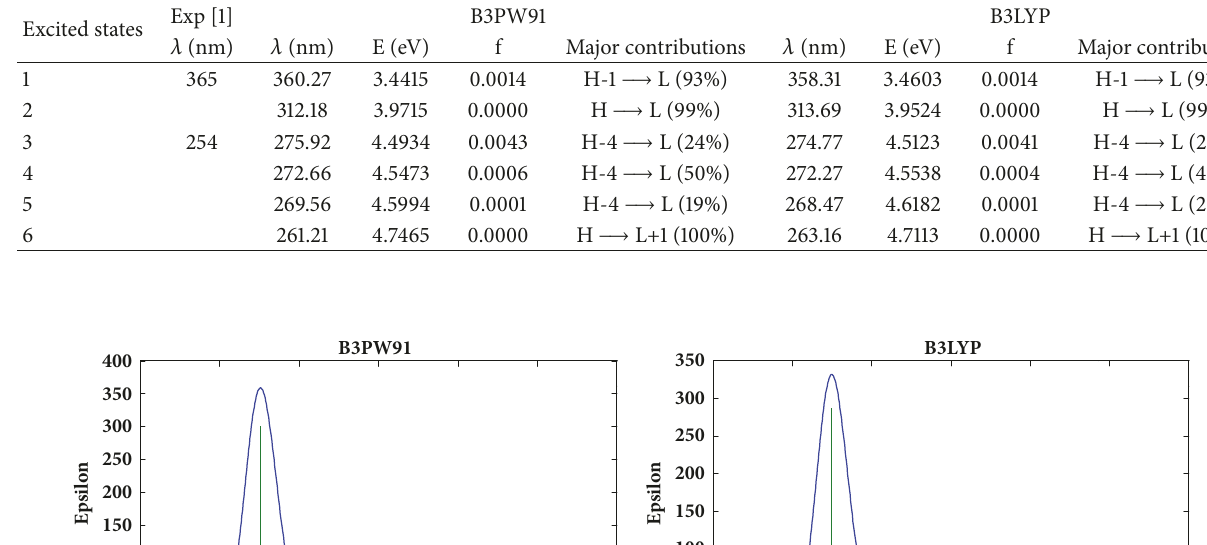
Table 4: Theoretical absorption wavelength ( 𝜆 ), excitation energy (E), and oscillator strengths of Rubescin E at the B3PW91 and B3LYP levels in gas with the 6-311++G(d,p) basis set.